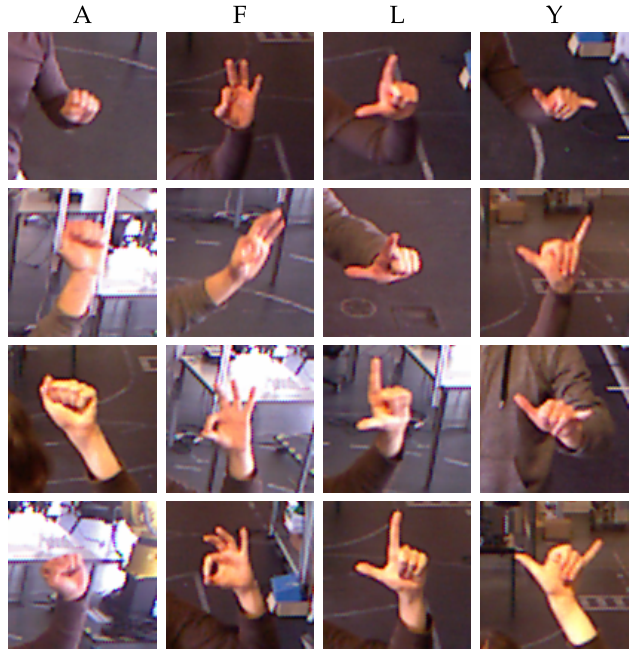
Figure 4. Examples of the test dataset with three different persons and acquired at different times of the day in relation to the training dataset. Each column is a class that is associated with an American Sign Language